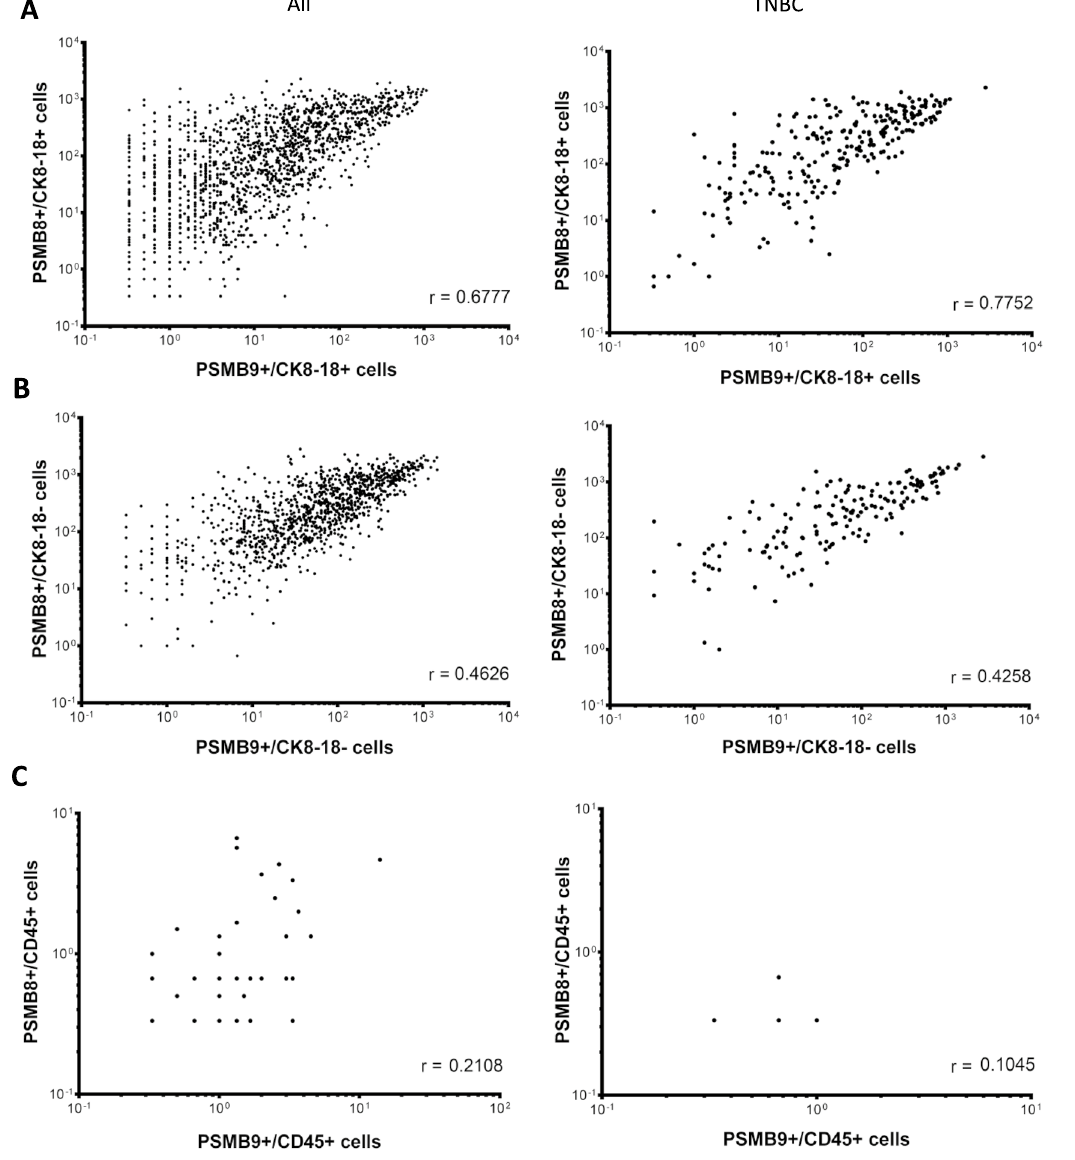
Figure 5. Numbers of PSMB8- and PSMB9-expressing cells correlate for all breast cancers and TNBC samples. Linear correlation regression analysis of protein expression for PSMB8 and PSMB9 in ( A ) tumor cells